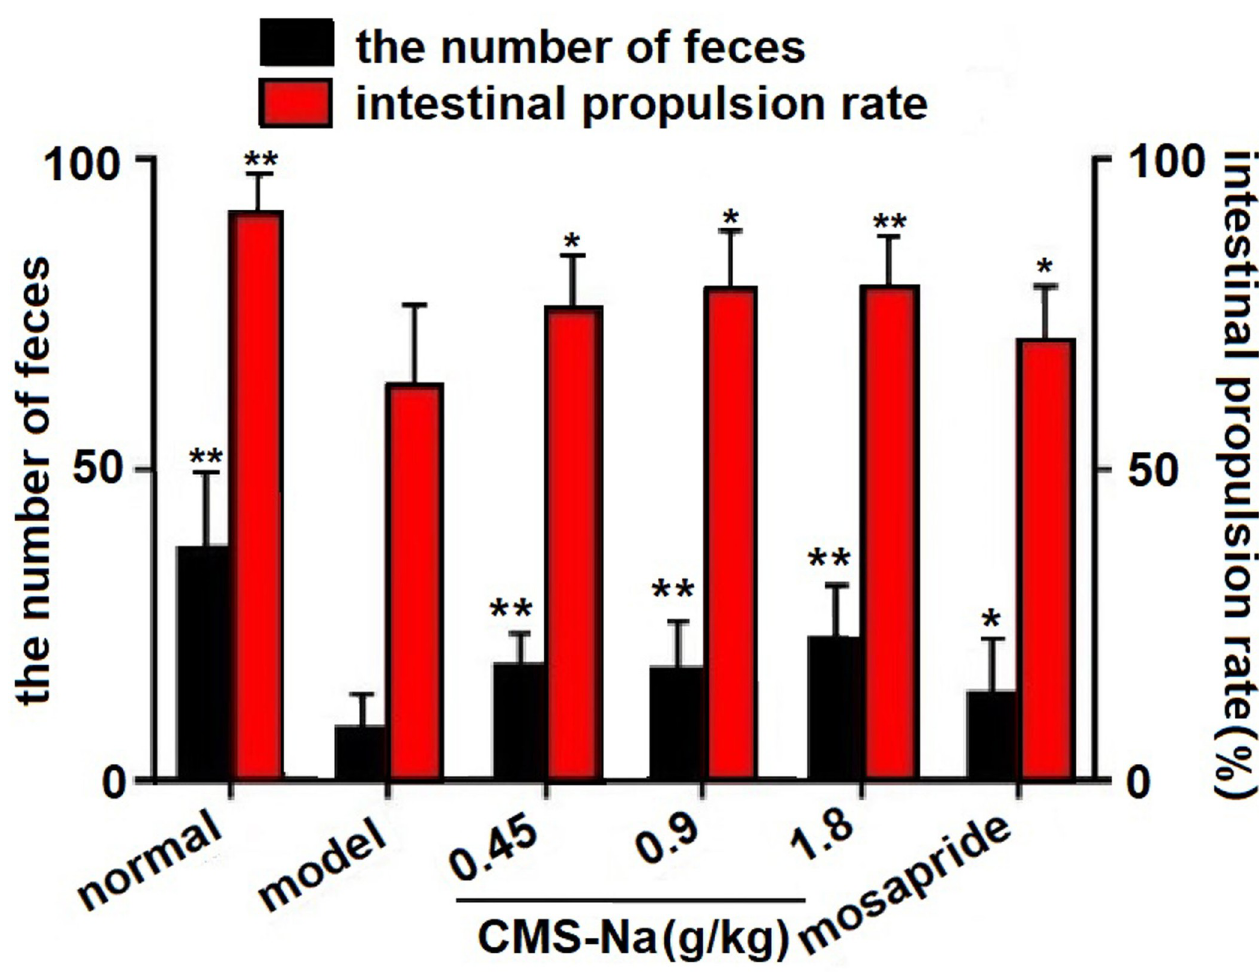
Fig 2. Effect of CMS-Na on defecation and intestinal propulsion in loperamide-induced constipated mice. Mice were given (ig) CMS-Na or mosapride after 3 h of loperamide once a day for 3 d. The fecal grains of mice were recorded for 3 h. After being fasting for 12 h, mice were gavaged with CMS-Na or mosapride. One and half hours later, mice were gavaged with red pitaya juice. Half an hour later, the small intestine was separated. The total length of the intestine and the intestinal propulsion length from the pylorus to the front of the red intestinal content were measured. Mean ± SD, n = 12, � P < 0.05, �� P < 0.01 vs. model; # P < 0.05 vs. mosapride. lower than that of the normal group (6.67 ± 0.14, 6.51 ± 0.08, 6.41 ± 0.08 vs. 6.84 ± 0.14; P < 0.05 or P < 0.01), suggesting that CMS-NA can reduce the intestinal pH of normal rats. Content of short-chain fatty acids in feces of normal rats It is presumed that intestinal microorganisms fermenting CMS-Na produces short-chain fatty acids (SCFAs) and lows intestinal pH. The contents of acetic acid, propionic acid and n- butyric acid of the feces in CMS-Na 1.2 g � kg -1 group significantly increased compared with the normal group (13.71 ± 2.4 μ mol/g vs.1.58 ± 0.24 μ mol/g, 7.38 ± 1.28 μ mol/g vs.0.21 ± 0.21 μ mol/g,